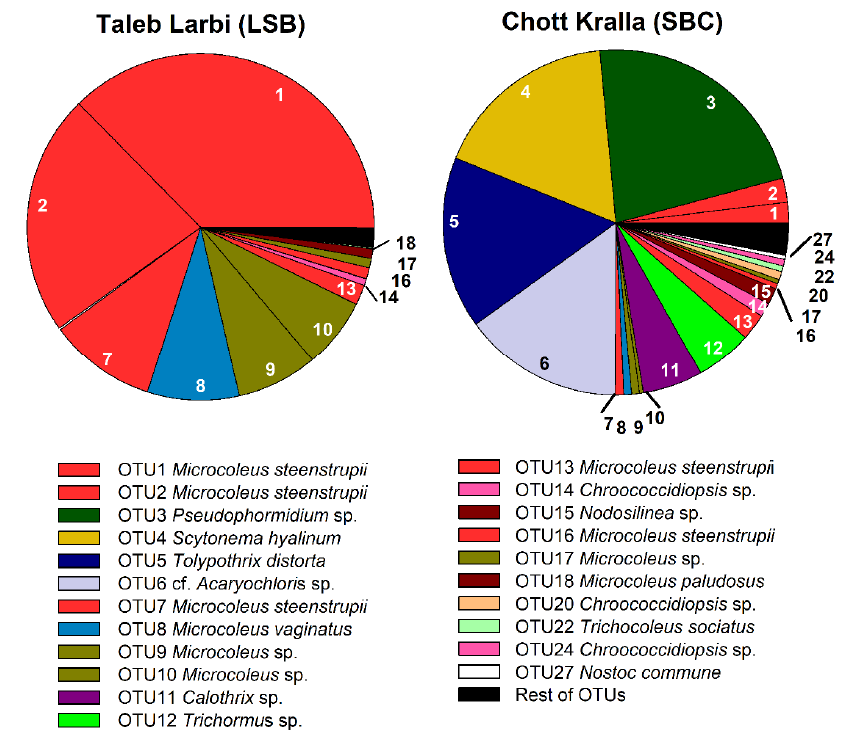
Figure 7. Cyanobacterial community composition from the studied biocrusts. Each taxon is repre- sented by a different color, and each OTU by a number (see Figure 6 for OTU numbers and taxo- nomic assignments). .SBC, Saline biocrusts; LSB, Less saline biocrusts.